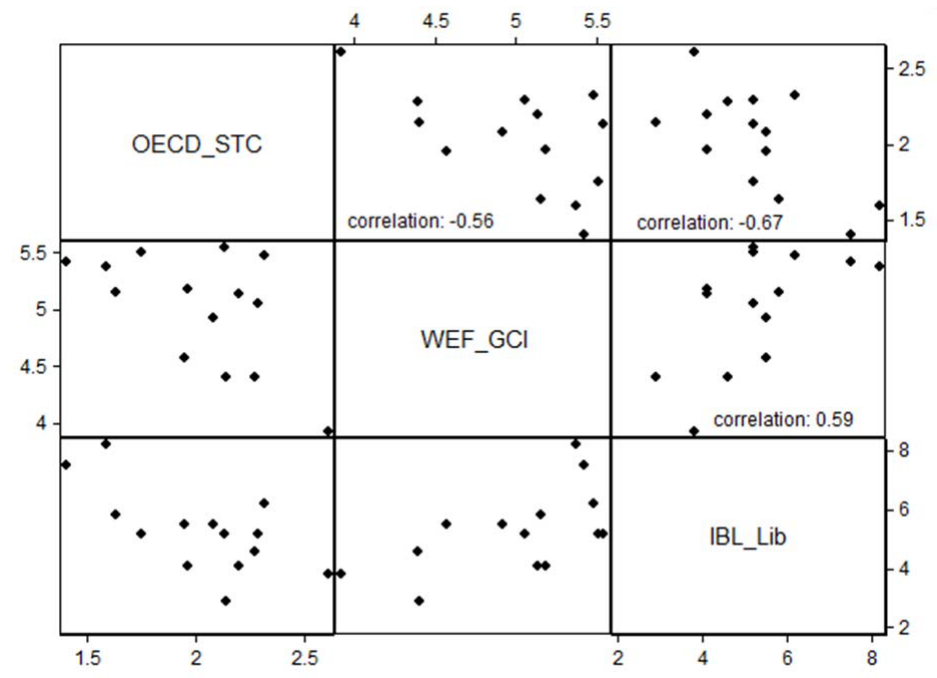
Graph 1: Correlation between IBL's Index of Liberalisations, WEF's Competitiveness index and OECD State Control